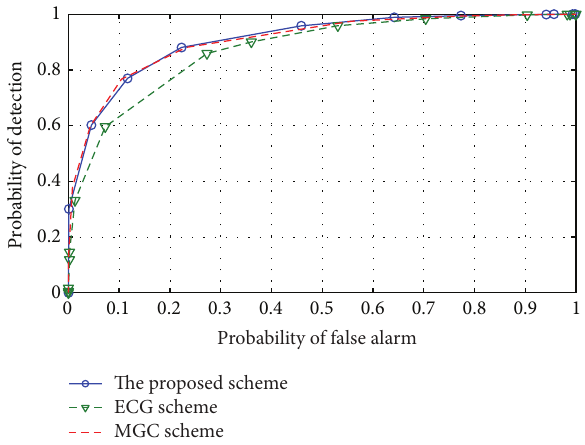
Figure2:ROCoftheproposedschemeandreferenceschemeswhen no malicious CU is considered.